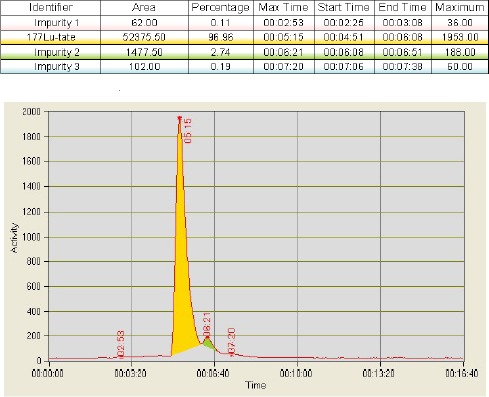
A typical chromatogram report for radiolabelled [177Lu]-DOTATATE product